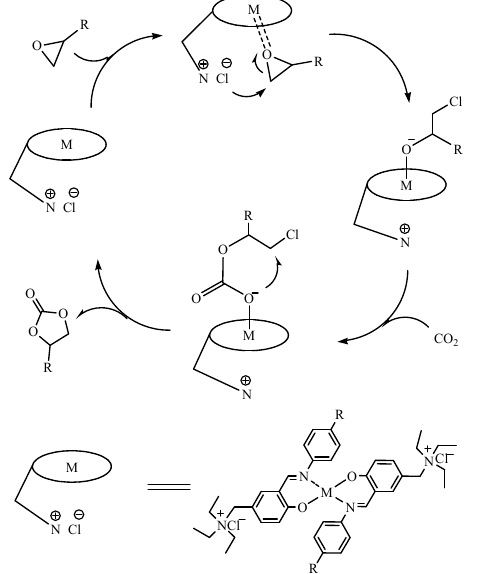
10 of 13 Figure 6. The activation energies ( E a ) for the cycloaddition of CO 2 and GIE catalyzed by M-NPClH. 4. Proposed Reaction Mechanism Based on the experimental results, kinetic study analysis, and previously reported literature [53 , 54], we proposed a possible mechanism for the cycloaddition reaction of CO 2 with epoxide (Scheme 3). The metal center of the catalyst activates the oxygen on the